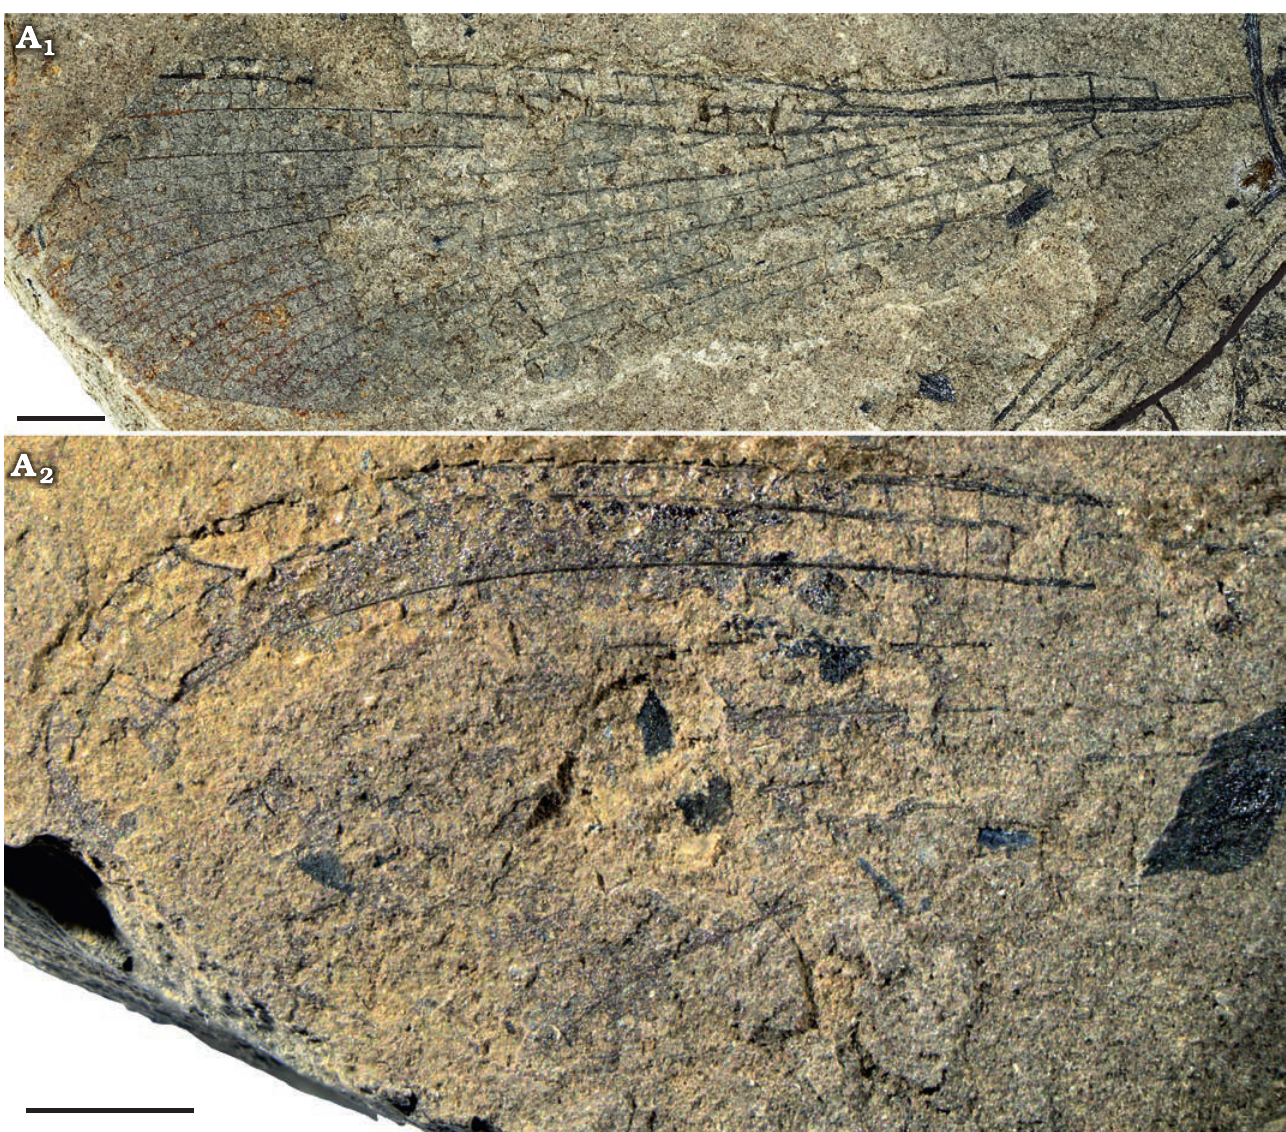
Fig. 4. Wing of zygopteran odonatan Menatagrion hervetae gen. et sp. nov., holotype MNT Nel Odo 1; from Paleocene, Menat, France. Counterimprint (A 1 ), wing apex, imprint (A 2 ). Scale bars 2